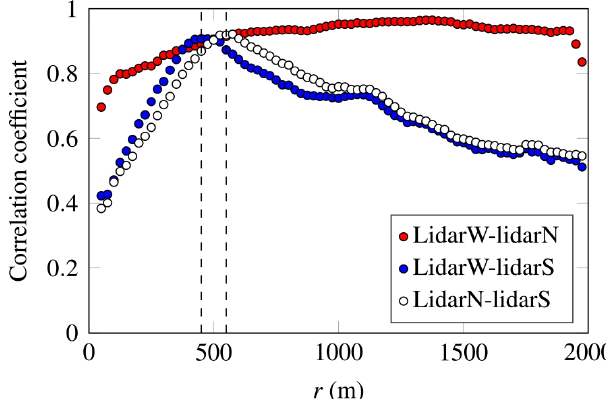
Figure 15. Pearson correlation coefficient between each pair of time series, at increasing distances from LidarW or LidarN. The dashed lines indicate the distance at which the correlation coefficient is largest for LidarW–LidarS and